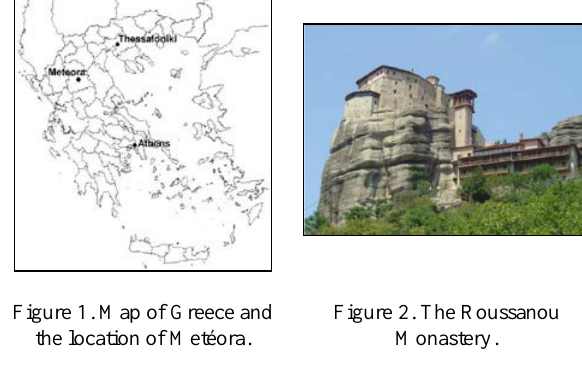
Figure 1. Map of Greece and the location of Metéora.